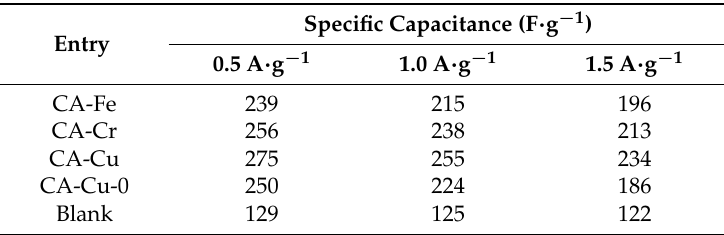
Figure 11. Galvanostatic charge-discharge curves at a current density of 1.0 A · g − 1 . Table 4. The specific capacitance of CA-X and the blank at different current densities.